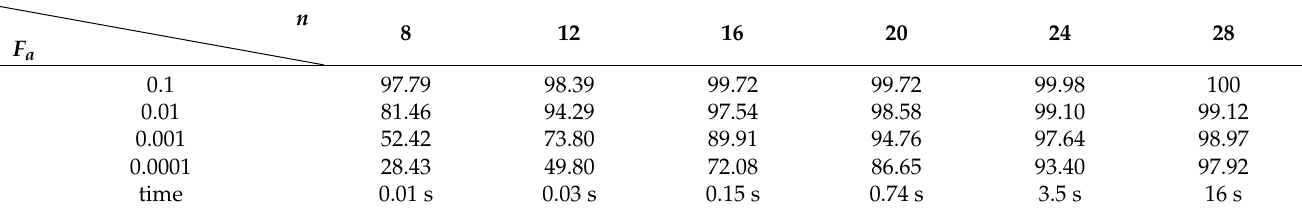
Table 4. P ( B | A ) when SCR is 1.5.